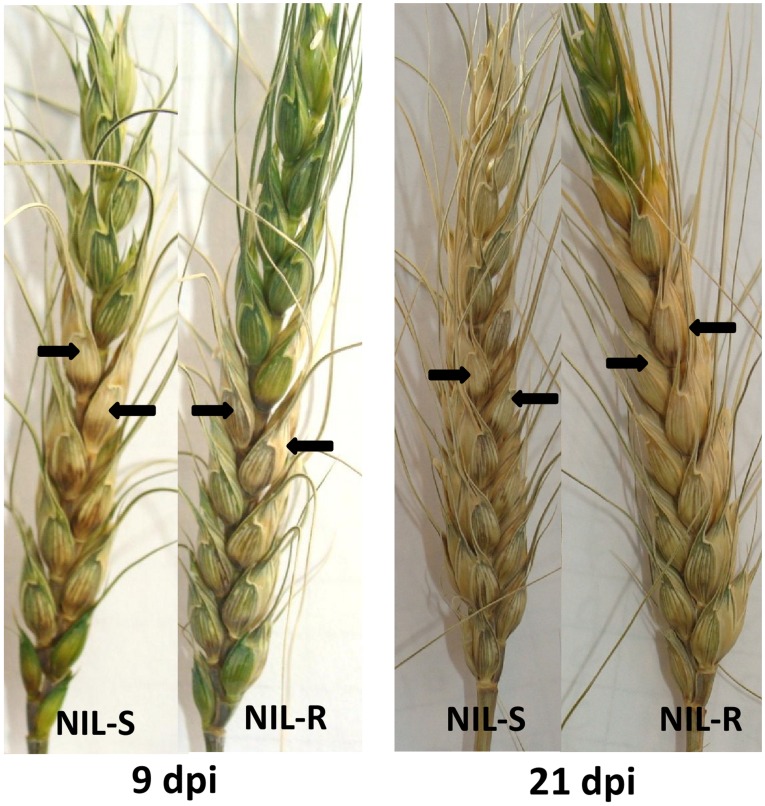

Fusarium graminearum infected spikes of wheat NILs with resistant and susceptible alleles of Fhb1, at 9 dpi and 21 dpi.Arrows indicate the site of point inoculation, NIL-R = NIL with resistant allele of Fhb1, NIL-S =  NIL with susceptible allele of Fhb1.